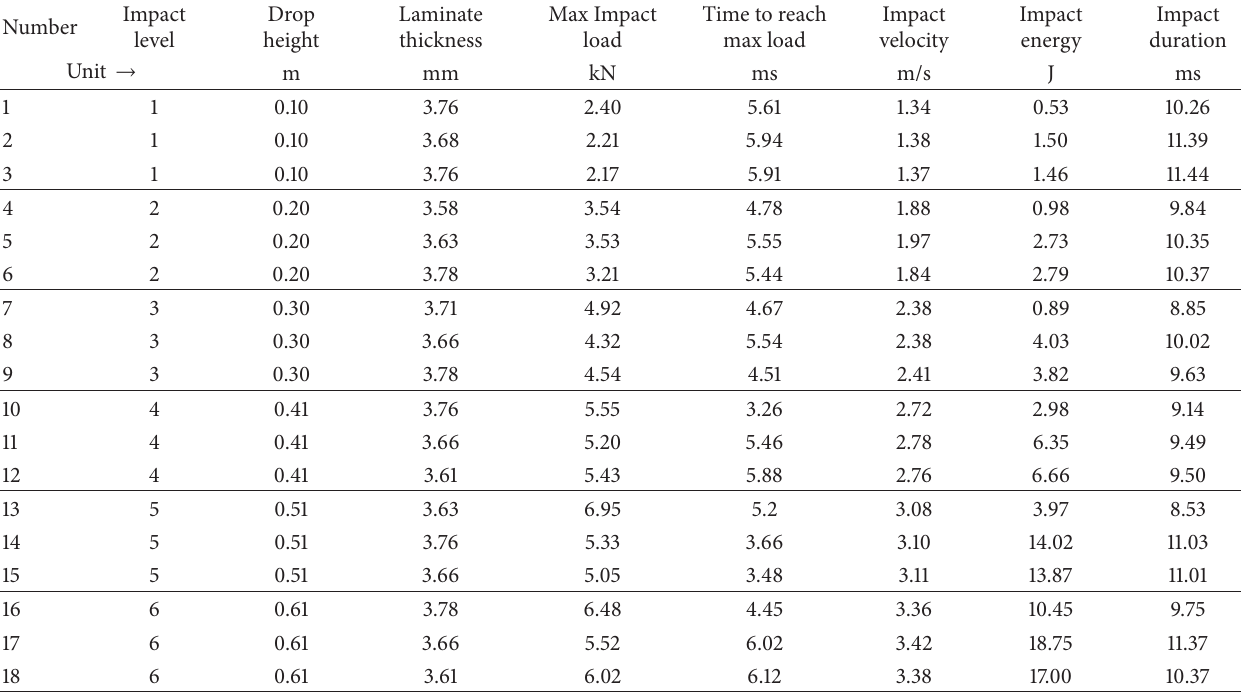
Table 6: Hybrid262 experimental